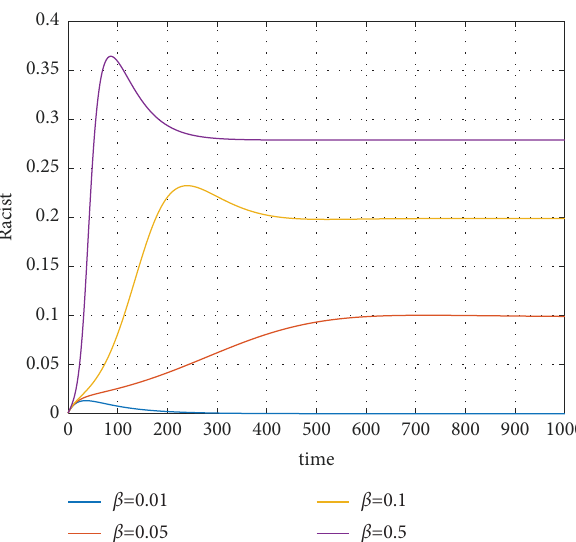
Figure 9: Te impact of β on racist class R ( t )